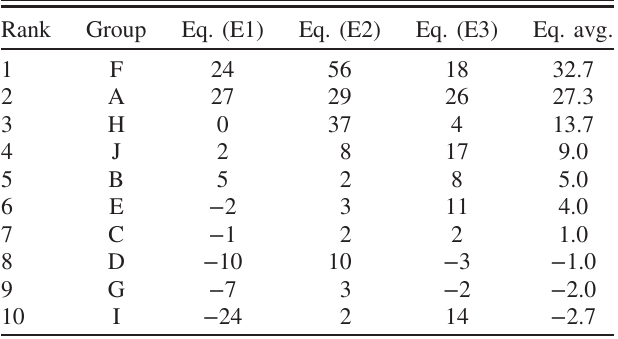
TABLE V. Group equality score (Eq.): Difference ( 2 þ 3 ) codes − ( 1 þ 4 ) codes ranked from overall highest to lowest. Rank